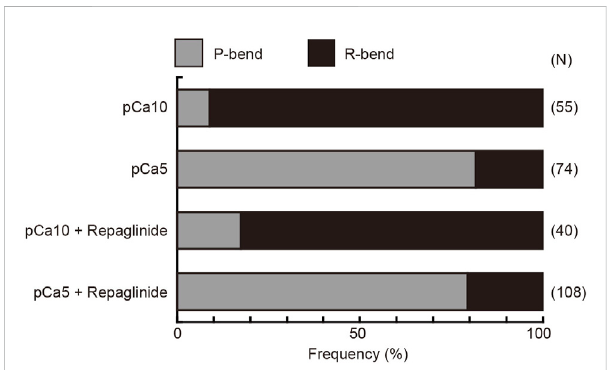
FIGURE 4 Preference for the direction of initial bend in the generation of symmetric and asymmetric fl agellar waveforms. The relative frequencies of principal (P) and reverse (R) bends are shown for the initial bends formed after activation of demembranated Ciona sperm. Sperm was reactivated by photolysis of caged ATP in low (pCa10) or high (pCa5) Ca 2+ concentrations in the presence of 0.5% DMSO (control) or 150 μ M repaglinide. In both control and repaglinide-treated sperm, the formation of fl agellar bends started with R-bends at pCa10, whereas it started with P-bends at pCa5. The number in brackets represents the number of observed spermatozoa in three different